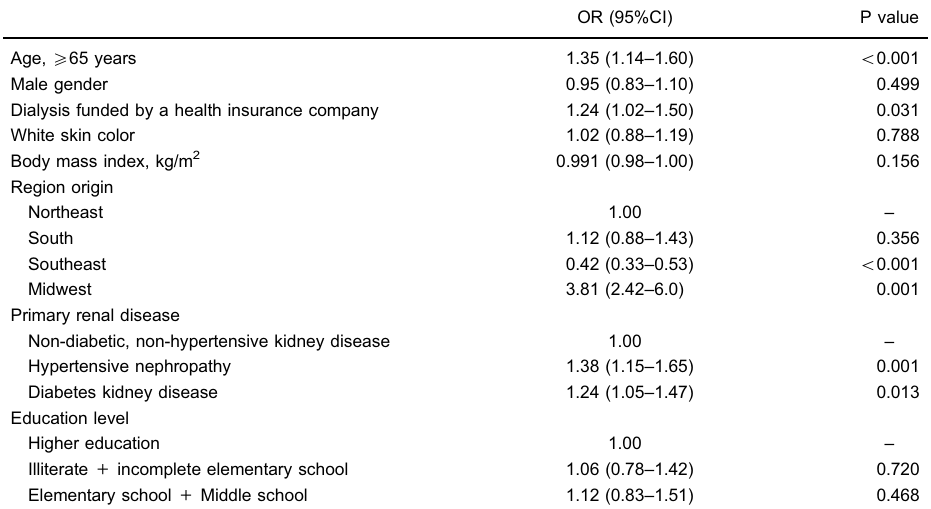
Table 3. Multivariate logistic multiple regression model to test for association with the use of a central venous catheter as the vascular access at the time of the onset of dialysis.